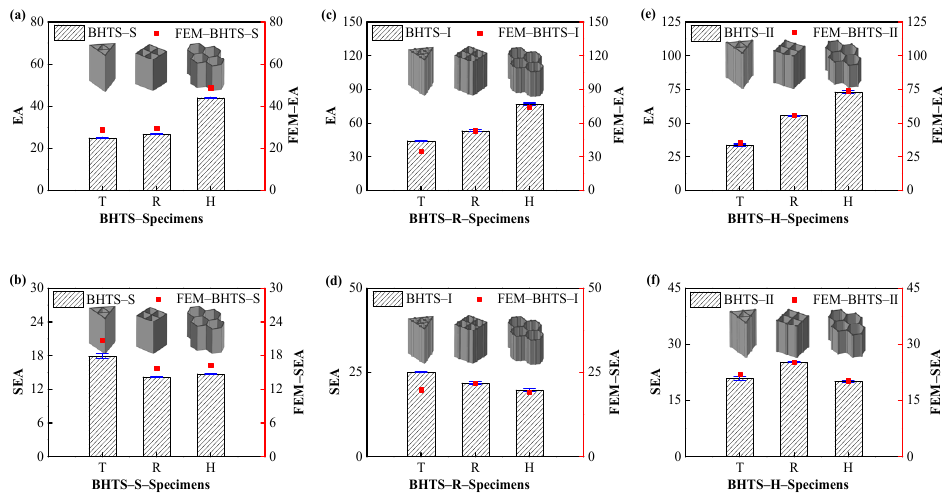
Figure 11. EA evaluation indexes of BHTS at different section angle number: ( a , c , e ) EA; ( b , d , f ) SEA.